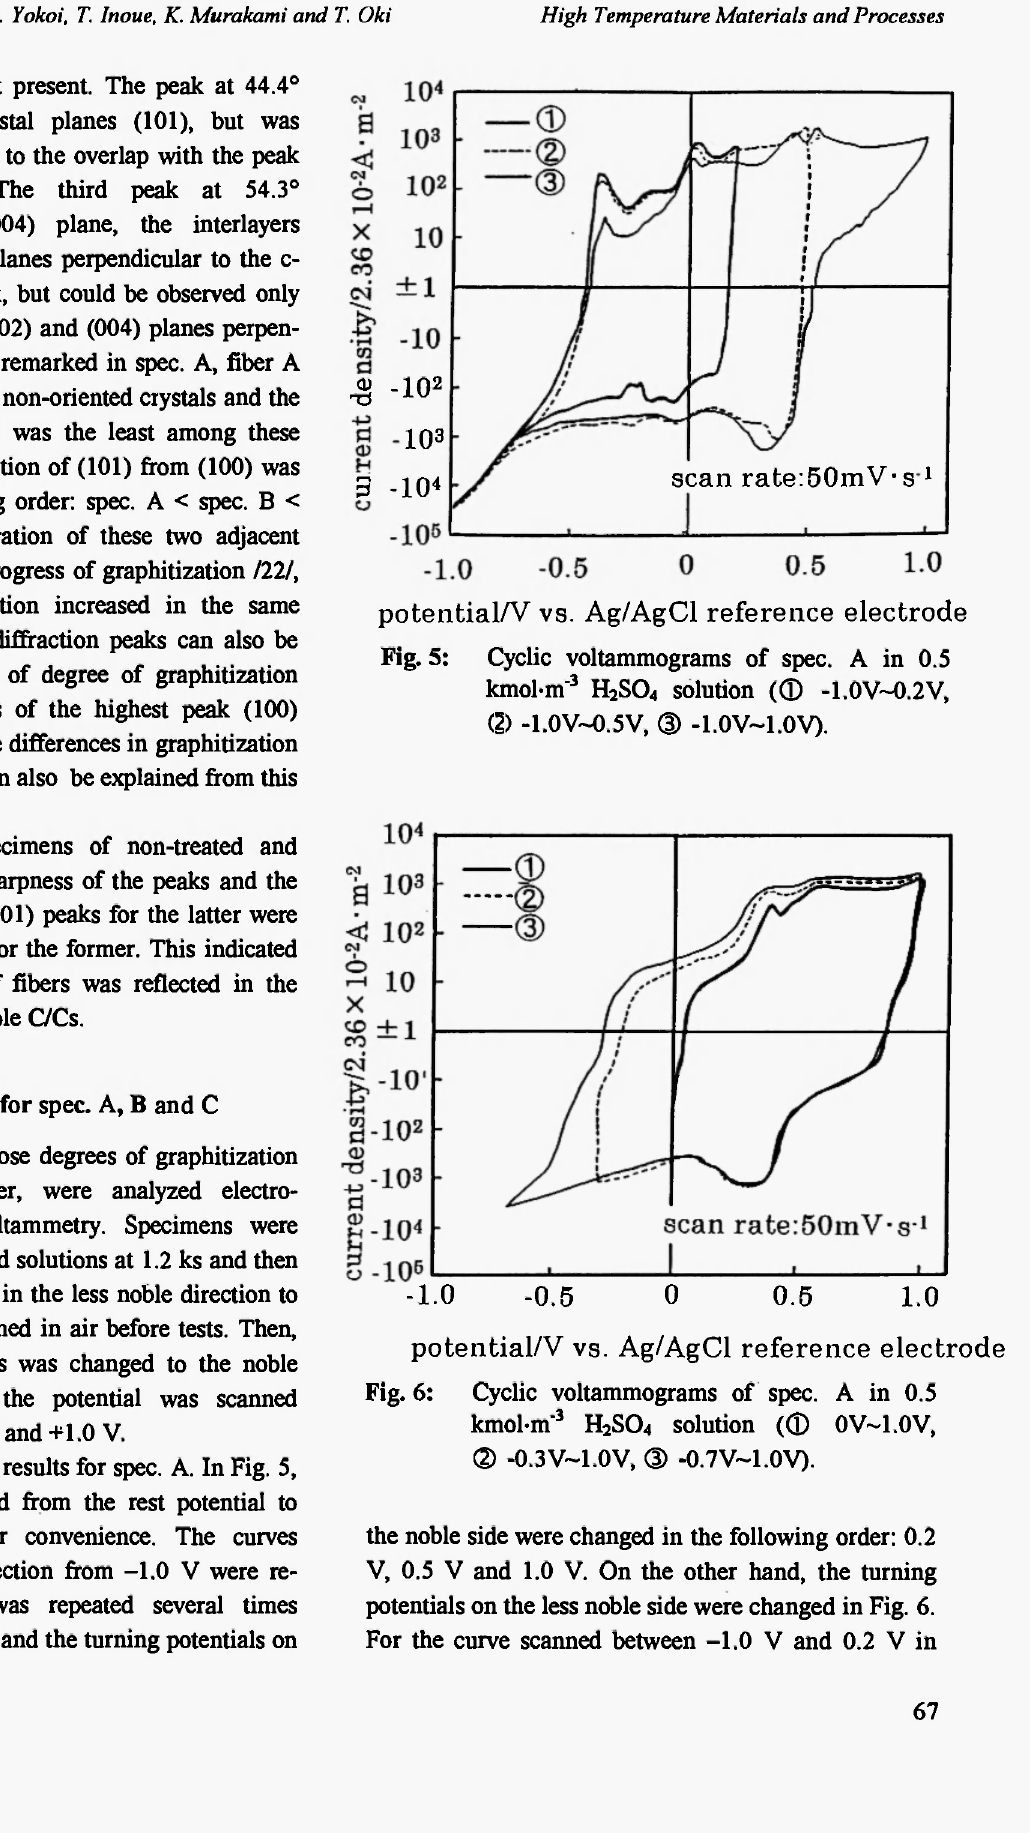
potential/V vs. Ag/AgCl reference electrode Fig. 6: Cyclic voltammograms of spec. A in 0.5 kmol-m· 3 H S0 solution (φ 0V-1.0V, 2 4 ® -0.3V~1.0V, (D -0.7V~1.0V).